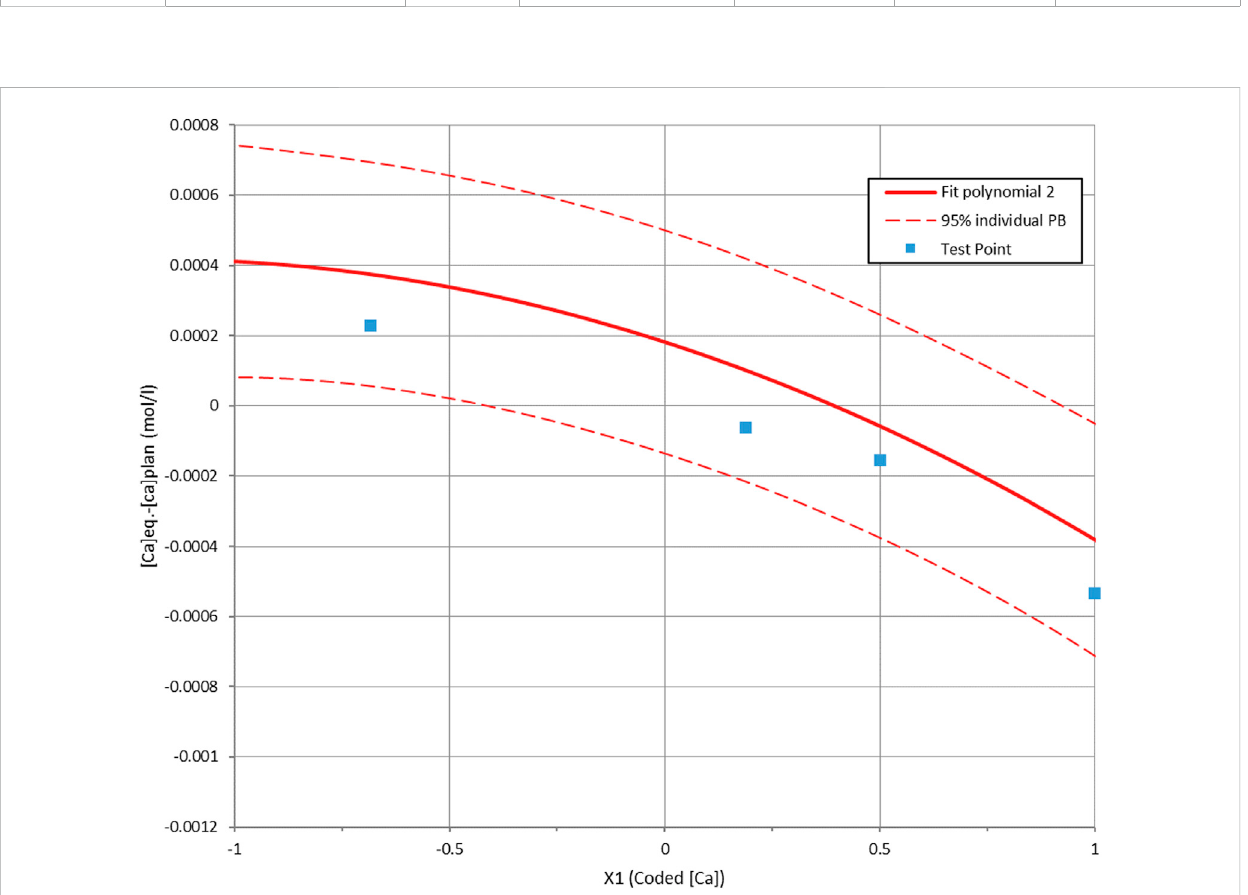
FIGURE 2 Model predictions for [Ca 2+ ] eq — [Ca 2+ ] plan together with the 95% prediction